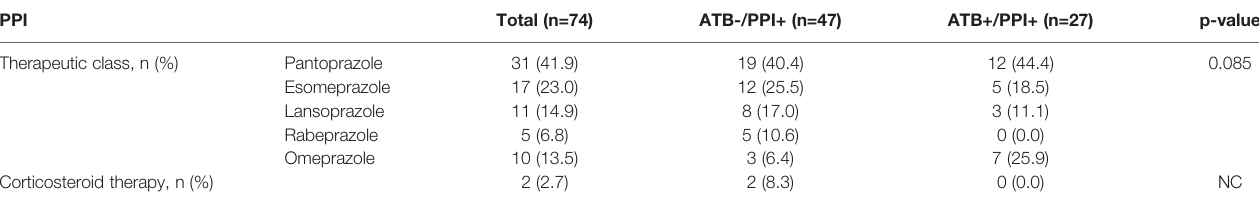
TABLE 3 | Characteristics of PPI use among the 74 patients with PPI and according to ATB use.